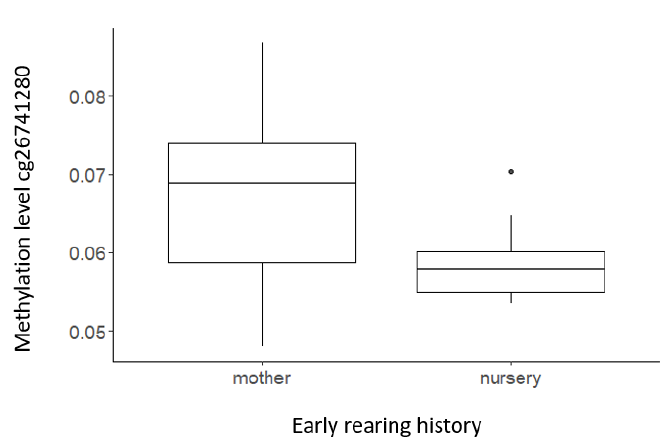
Figure 2. Impact of early rearing history on methylation scores for cg26741280.